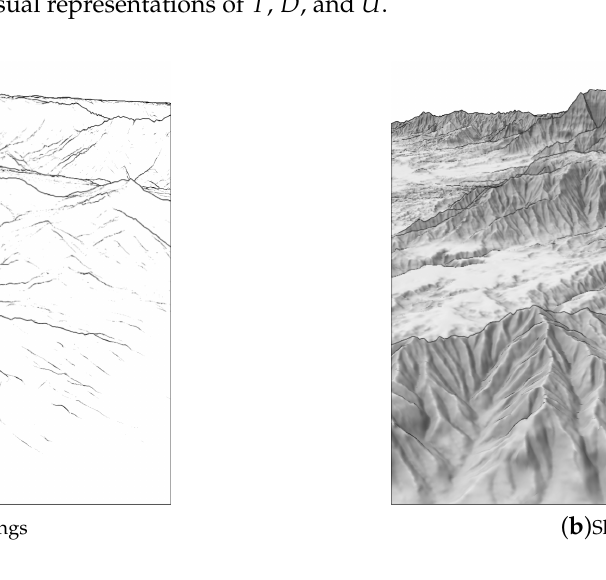
Figure 2. Strategies for terrain. ( a ) Line drawing provides an overview of basic terrain features; ( b ) Shading represents the terrain at high